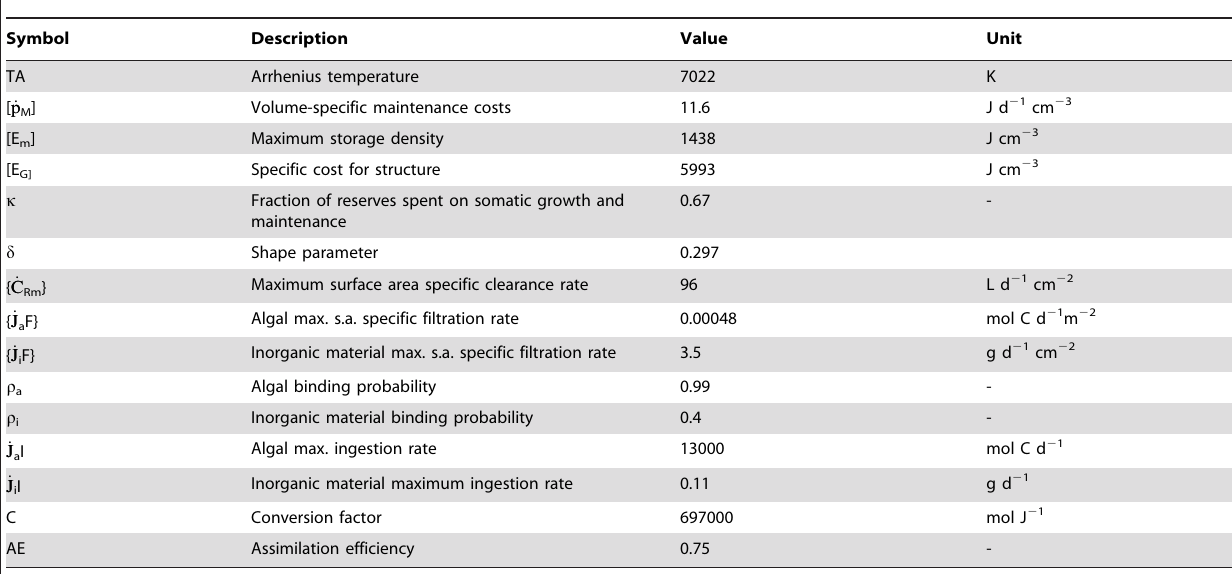
Table 1. DEB parameters and